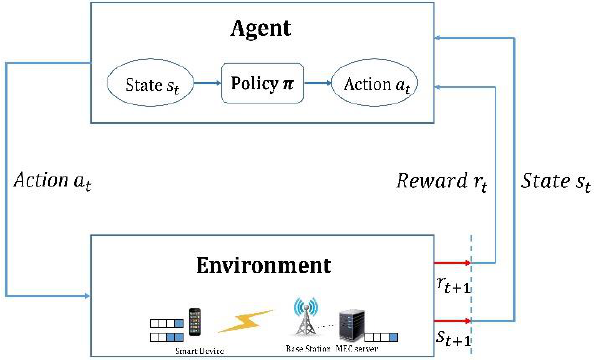
Figure 1. Reinforcement